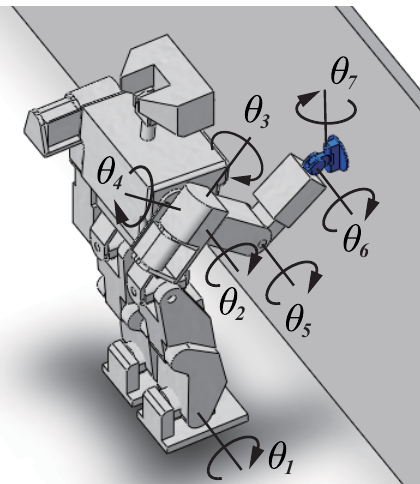
Figure 13. A small humanoid robot cleaning a vertical surface: spa-